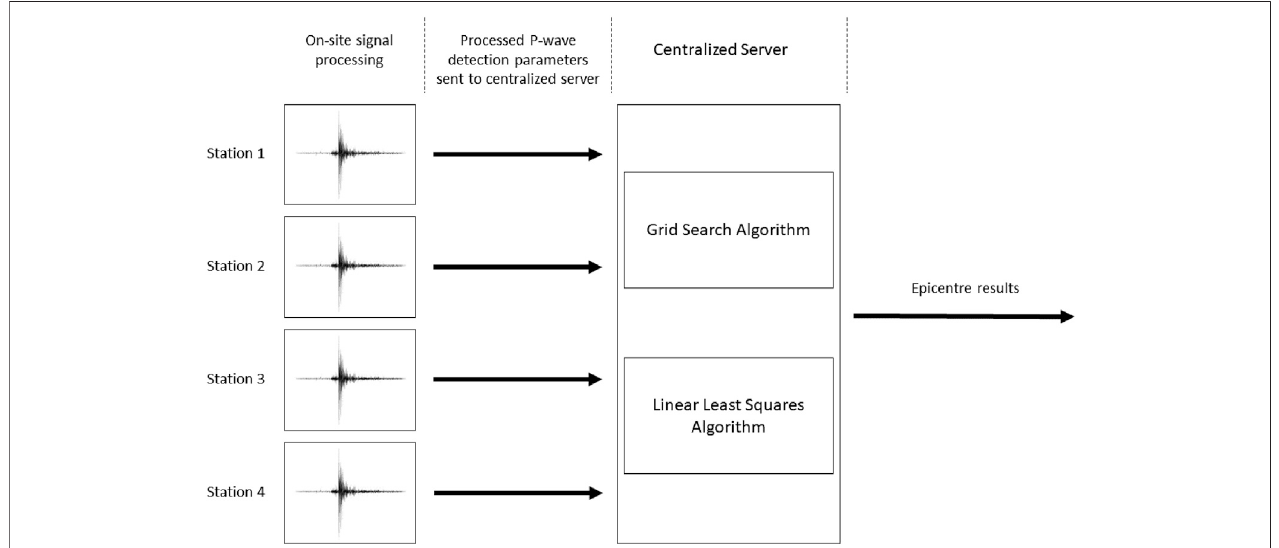
FIGURE 2 | Schematic representation of the EEW detection process. The waveform data are processed on site and the detection parameter are sent to a centralizedserver.Therethetwoalgorithms,DirectGridSearch(DGS)andLinearizedLeastSquares(LLS)methodareindependentlycalculatinganepicentrelocation.A more detailed schematic for the EEW system is shown in Figure 4